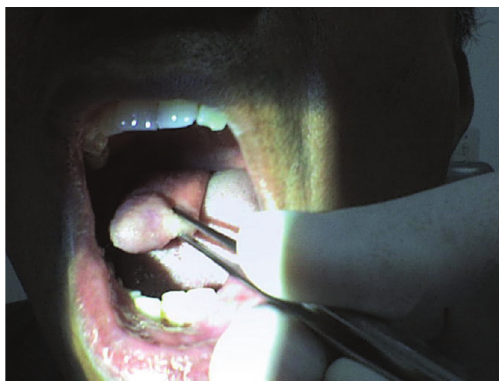
Figure 3: Excised lesion.